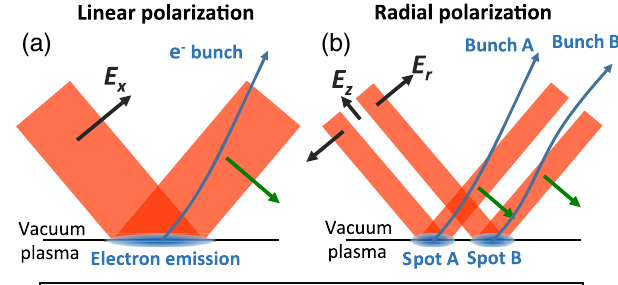
FIG. 9. Schematic illustration of electron emission from the plasma in the incident plane for linear (a) and radial (b) polari- zation. The black arrows represent the incident electric field. The green arrows in the reflected field indicate the direction of the transverse electric field seen by the electrons immediately after they are injected. The electrons are always emitted at a phase of the laser field such that they tend to deviate towards the normal direction (this implies, in particular, that the time at which electrons are ejected is shifted by half a laser period between spot A and spot B). For radial polarization, the electrons originating from spot B are more likely to interact with the E z field than those coming from spot